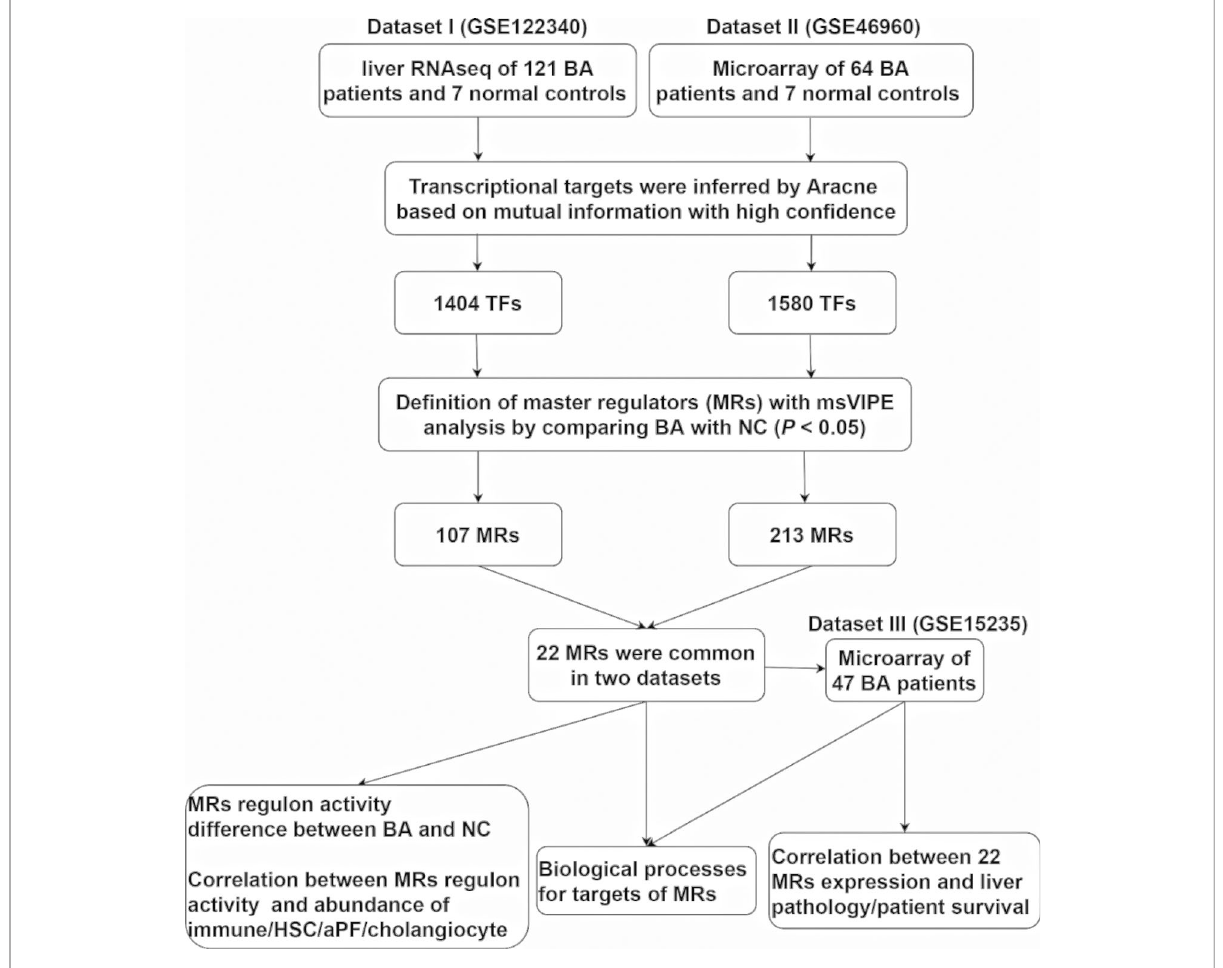
FIGURE 1 An outline of the systems biology analytical pipeline used in this